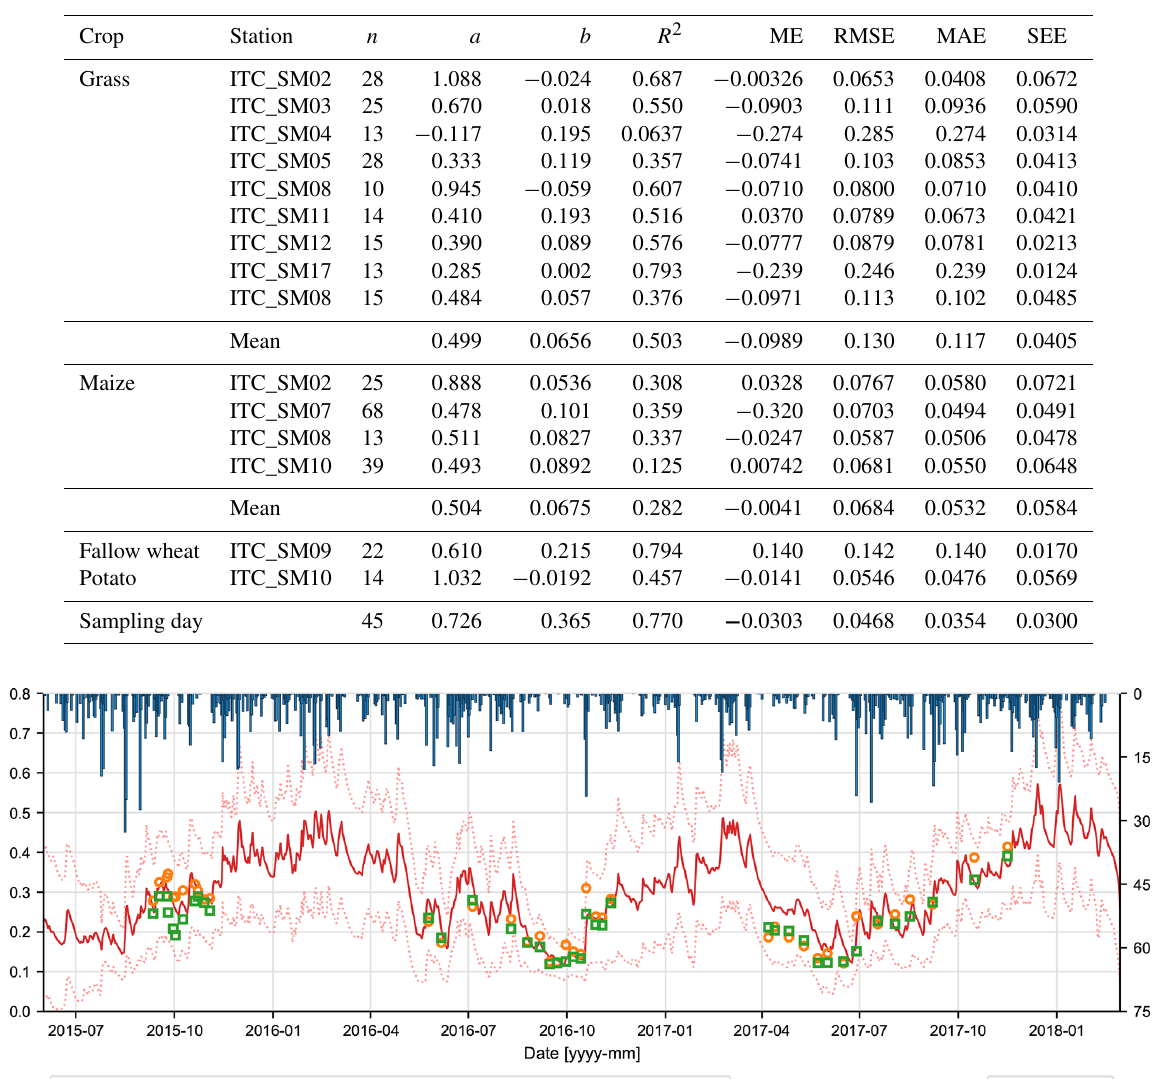
Table 5. The number of matchups and performance metrics computed between the field-averaged and matching station VSM including the RMSE, ME, coefficients a and b of the linearly regressed line, R 2 , and standard error of estimate (SEE).